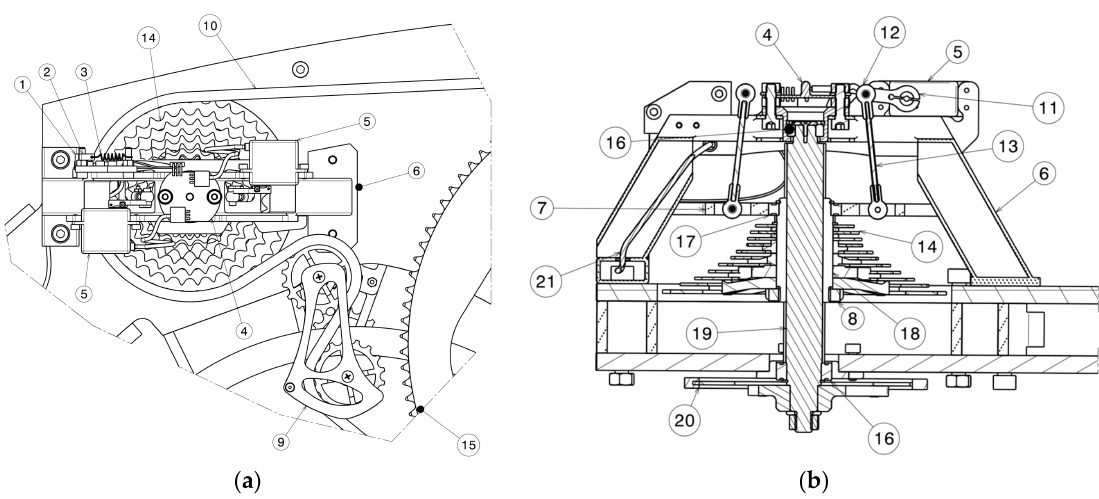
Figure 3. First version of the moving cassette gear-shift: ( a ) lateral view; and ( b ) top section